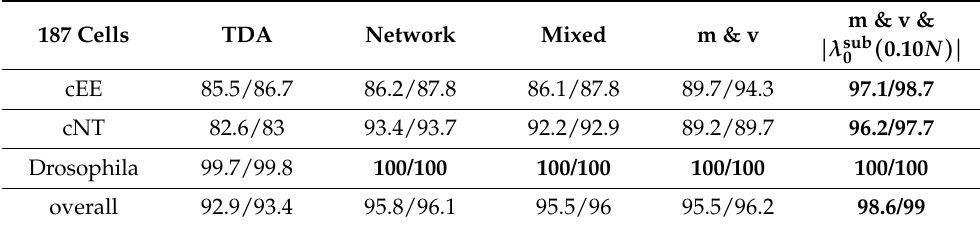
( 0.10 N ) | . The accuracy 0 m & v